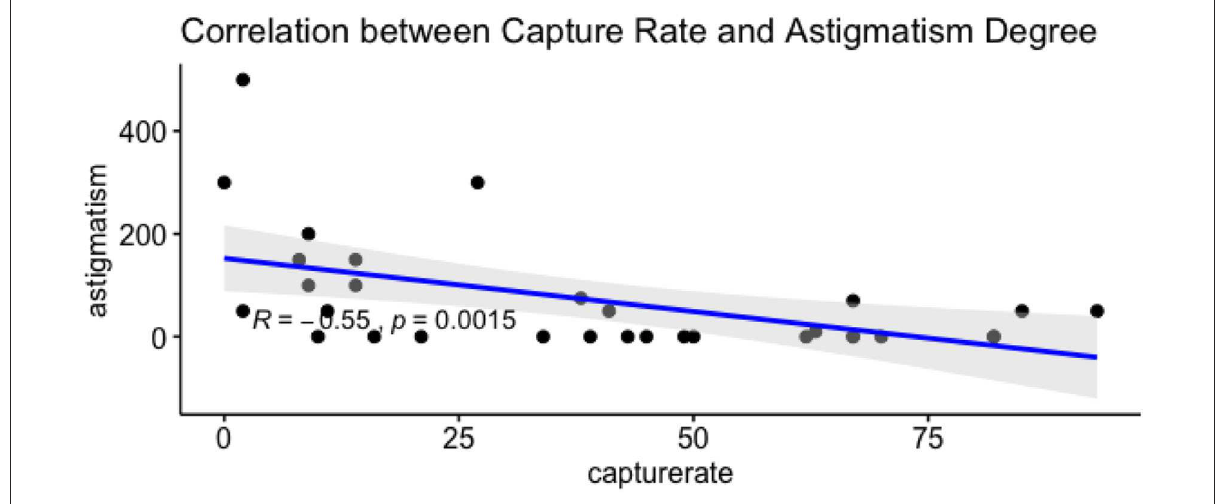
FIGURE6 The correlation between capture rate and astigmatism